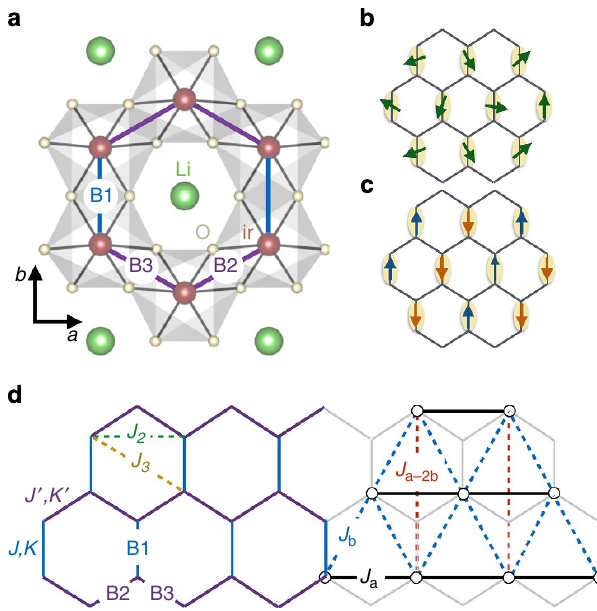
Figure 1 | Honeycomb structure of Li 2 IrO 3 and mapping onto an effective triangular lattice of triplet spins. ( a ) The two distinct sets of NN links 26 are labelled as B1 (along the crystallographic b axis) and B2/B3. ( b ) The large FM interaction J ¼ (cid:2) 19.2meV on B1 bonds stabilizes rigid T ¼ 1 triplets that frame an effective triangular lattice. The triplet dimers remain protected in a wide region of the phase diagram, including the incommensurate ICx and ( c ) diagonal-zigzag phase, see text. ( d ) Representative exchange couplings for B1 ( J , K ), B2/B3 ( J 0 , K 0 ), second neighbour ( J 2 ) and third neighbour ( J 3 ) paths on the original hexagonal grid are shown. J d ( d A { a , b , a (cid:2) 2 b }) are isotropic exchange interactions on the effective triangular